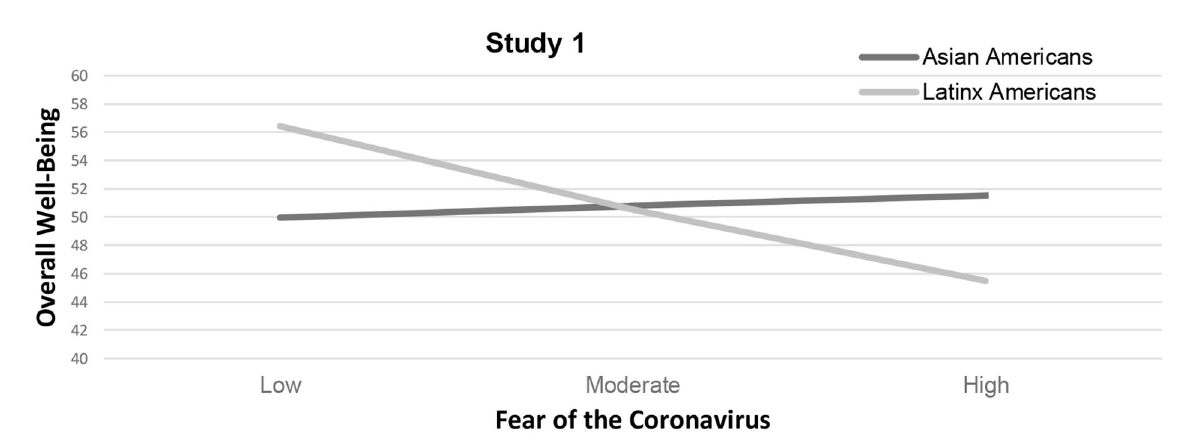
FIGURE3 Changes in overall well-being as a function of race and fear of the coronavirus for study 1. Note . Results suggest race as a significant moderator ( p < 0.05) for the relationship between fear of the coronavirus and overall well-being. Latinx Americans experienced lower overall well-being as a function of fear of the coronavirus compared to Asian